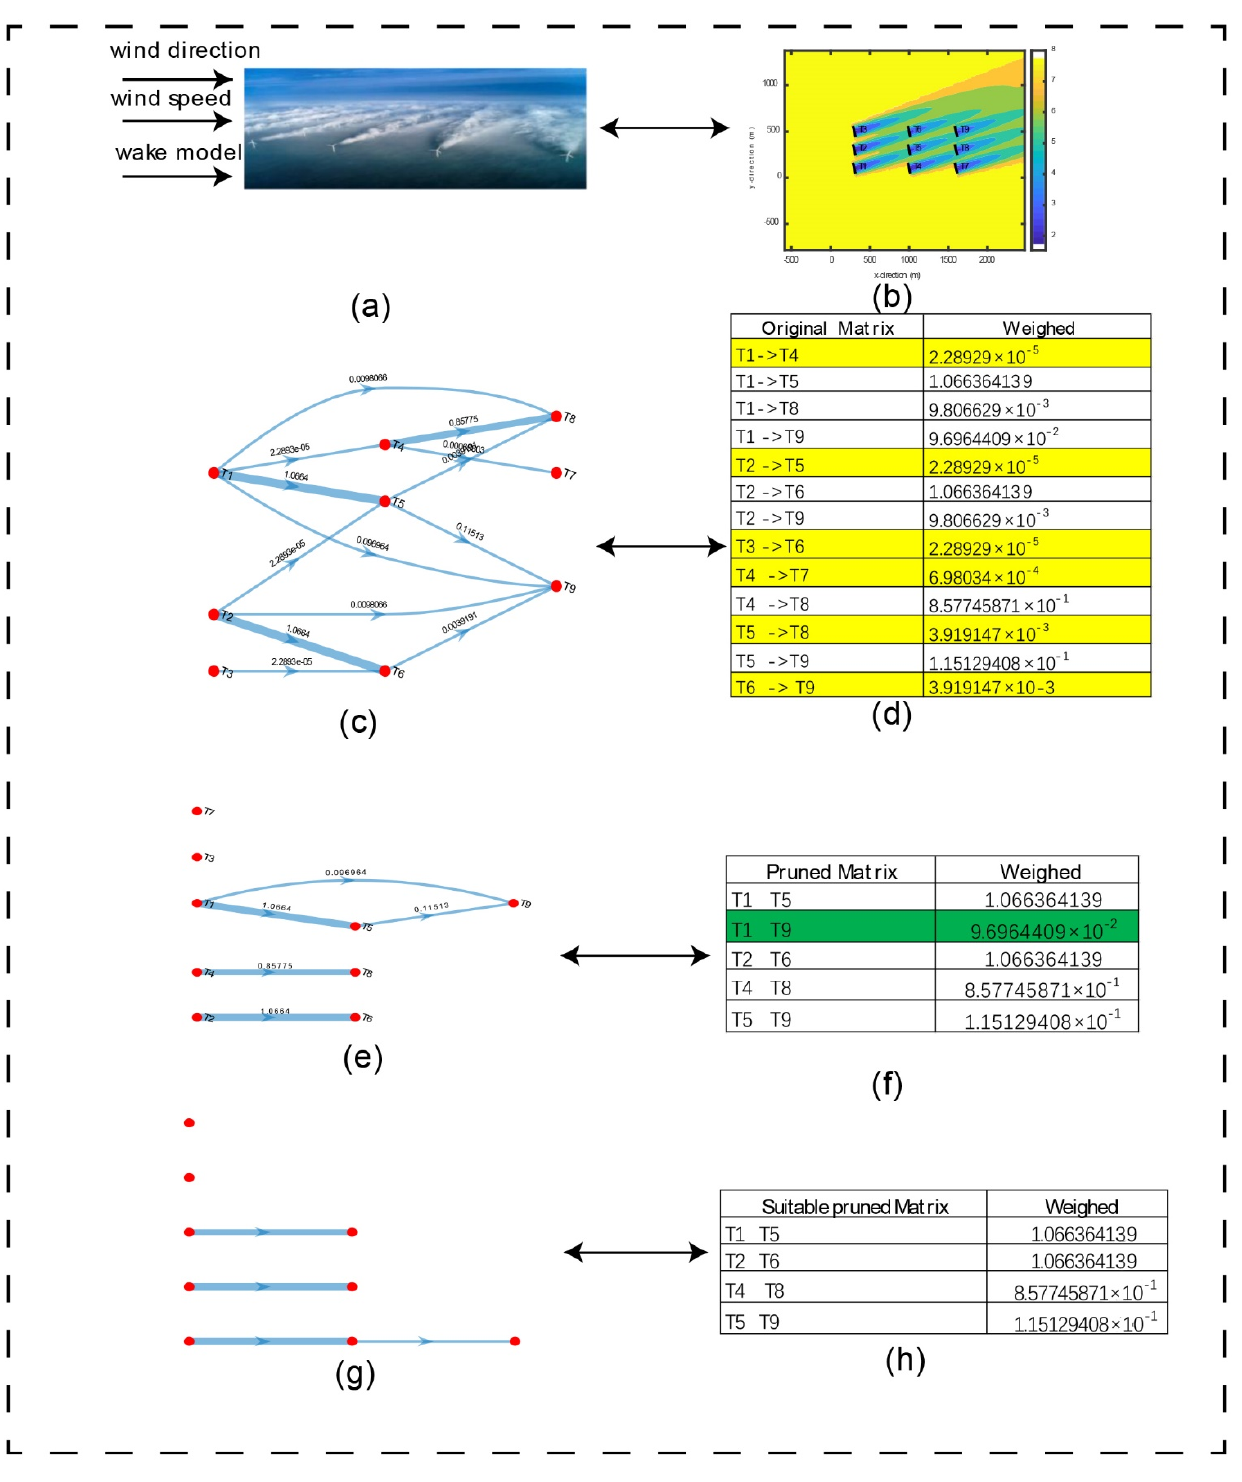
Figure 1. The proposed whole decentralized control scheme on a 3 × 3 matrix OWF with V ∞ = 8 m/s, ϕ = 15 ◦ : ( a ) Wind Farm; ( b ) wake field; ( c ) original wake digraph; ( d ) turbine original matrix; ( e ) pruned wake digraph with k = 3.2; ( f ) turbine pruned matrix with k = 3.2; ( g ) pruned wake digraph with k = 5.1; ( h ) turbine pruned matrix with k = 5.1.